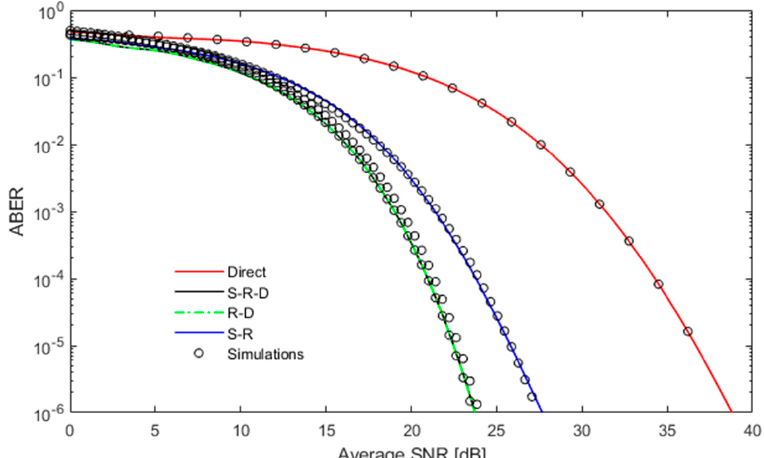
Figure 4. Average bit error rate (ABER) vs. SNR of Free Space Optics (FSO) over L-N channel for weak turbulence with distance 400–600 m, and the number of relays = 3, and w z = 2 m.